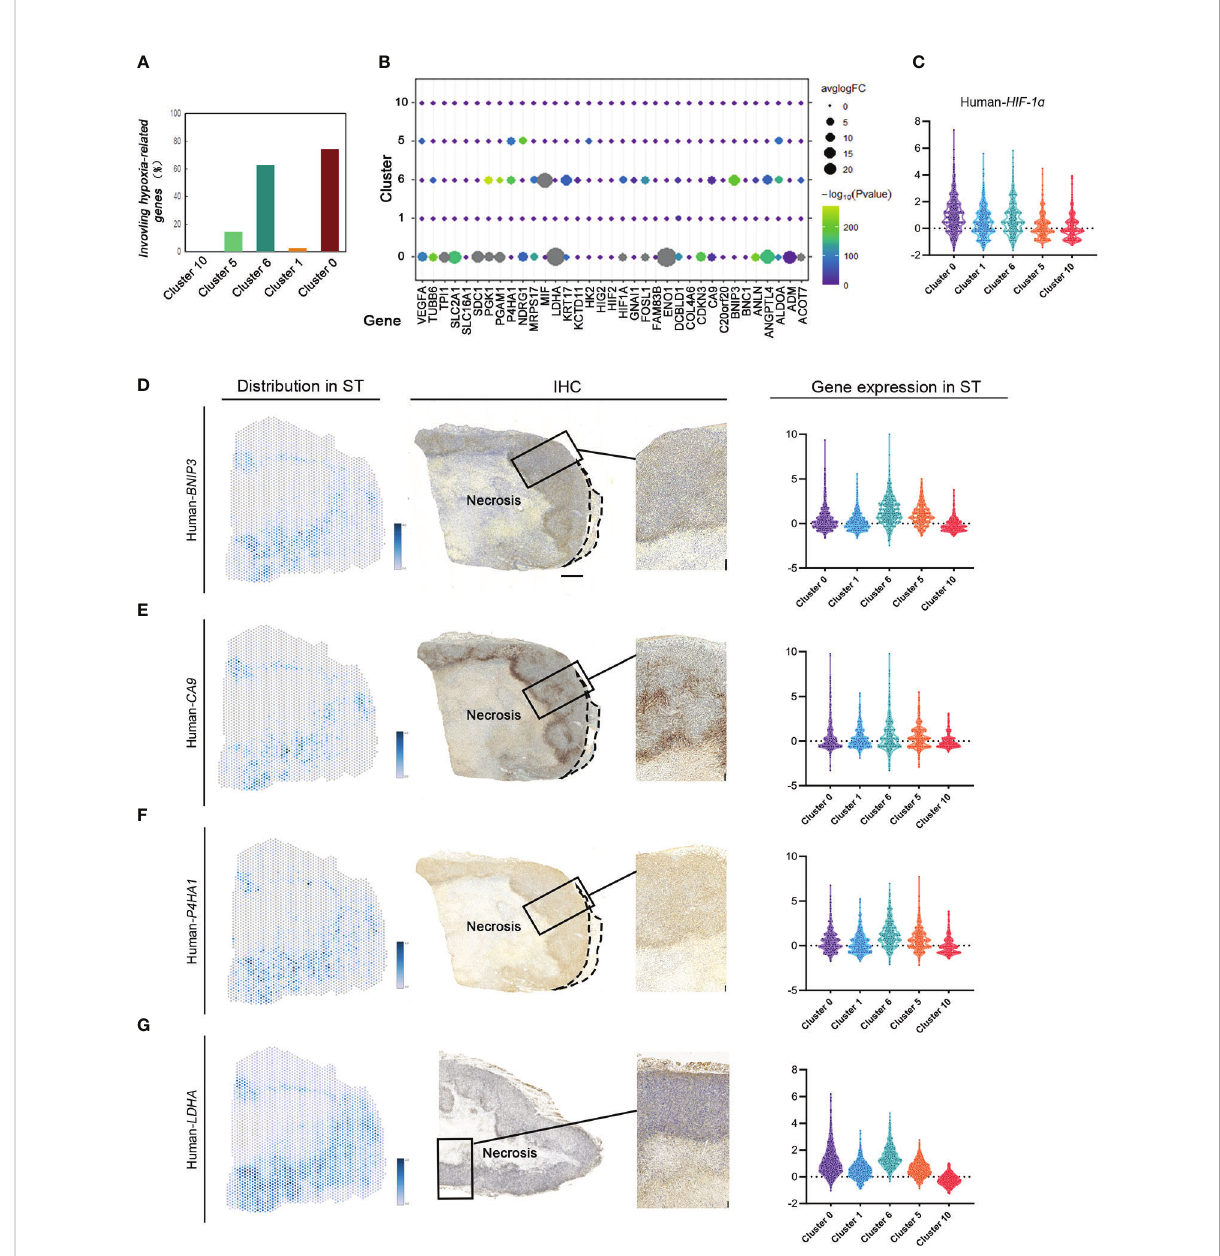
FIGURE 3 ST identi fi es hypoxia-related gene expression and distribution based on different hypoxic conditions in MDA-MB-231 engrafts. (A) Number of hypoxia-related genes in cluster 0, cluster 1, cluster 6, cluster 5, and cluster 10. (B) Distribution of hypoxia-related genes in different clusters. (C) Violin plots of HIF1A expression in cluster 0, cluster 1, cluster 6, cluster 5, and cluster 10. (D – G) Spatial feature plots of Human BINP3, CA9, P4HA1, and LDHA in sample (C) IHC for human BINP3, CA9, and P4HA1 in sample C and LDHA in sample B (scale bar, 1 mm). Violin plots of these genes ’ expression in cluster 0, cluster 1, cluster 6, cluster 5, and cluster